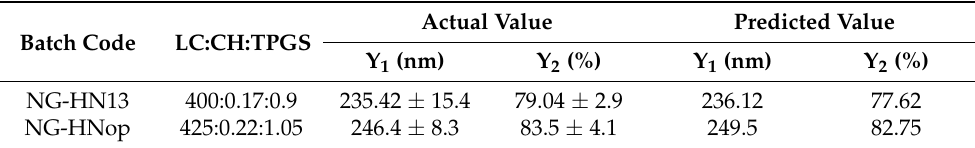
Table 4. Point prediction optimization using the Box–Behnken design.